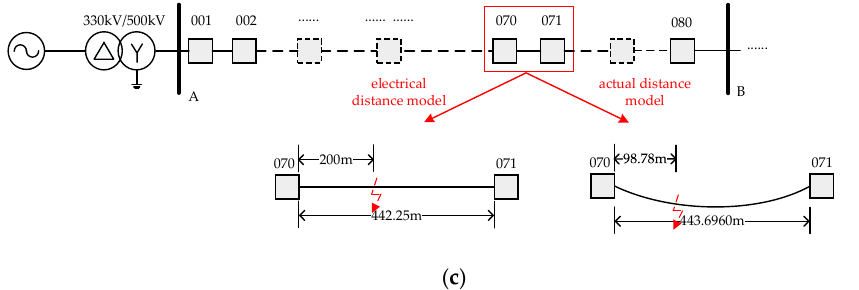
Figure 6. The model of the transmission line when faults happen ( a ) in different parts of the line, ( b ) in the middle of the line, and ( c ) at the tail of the line.